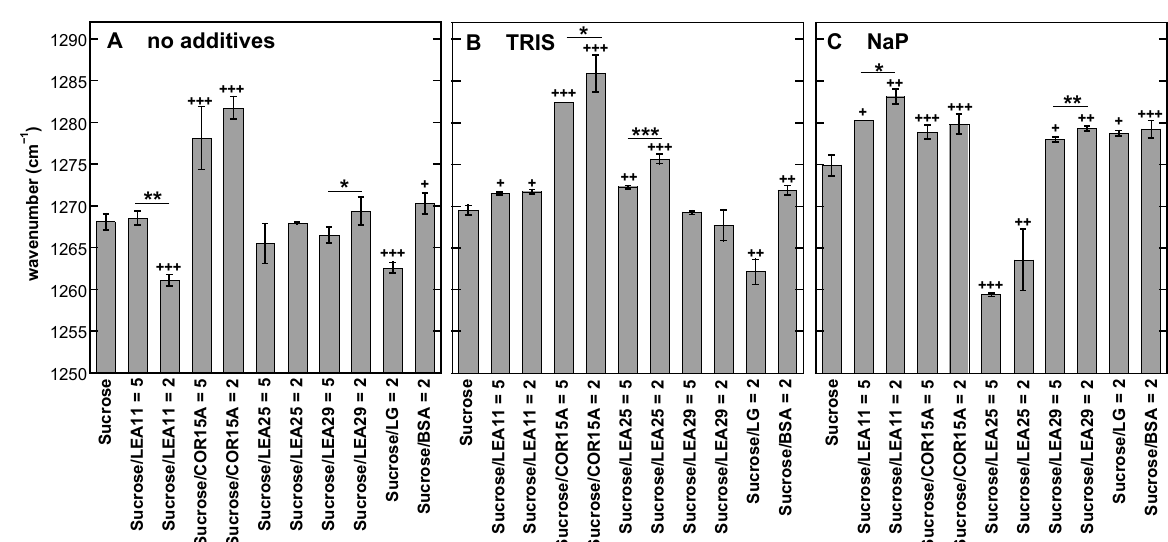
Figure 10. Influence of the presence of buffers and proteins on the position of the absorbance peak located at about 1268 cm − 1 in a pure Suc glass. Samples contained either pure Suc or, in addition, the proteins LEA11, COR15A, LEA25, LEA29, β -lactoglobulin (LG) or bovine serum albumin (BSA). All solutions contained 10 mg/mL Suc and were prepared in H 2 O ( A ), 10 mM Tris ( B ) or 10 mM NaP buffer (pH 7.4) ( C ). Samples were dried on CaF 2 windows, and spectra were recorded at 30 °C. Values are means from at least three parallel samples ± standard deviation. Statistically significant differences between the values determined at the two different Suc/LEA mass ratios are indicated by *, while significant differences between the values obtained in the presence of the different proteins and pure Suc are indicated by + (*, + ˂ 0.05; **, ++ ˂ 0.01, ***, +++ ˂ 0.001).